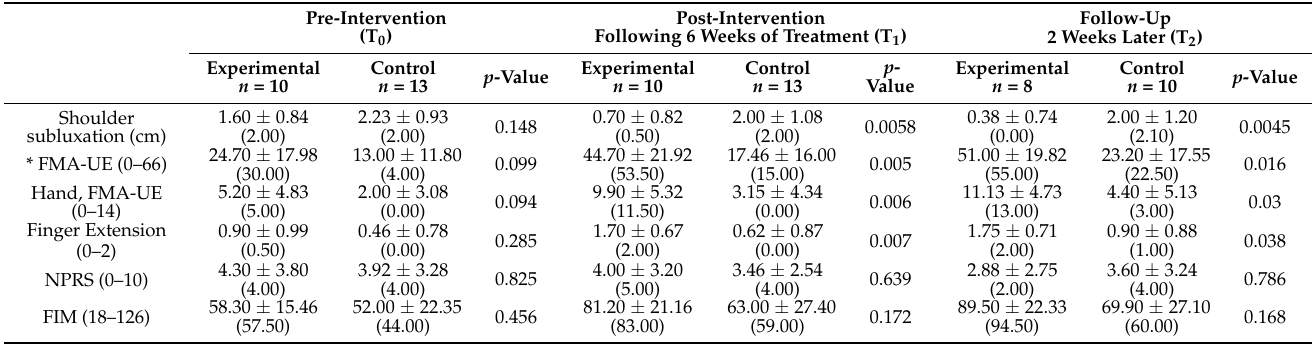
Table 2. Outcome measures pre- and post-intervention following 6 weeks of treatment and at follow-up 2 weeks later per group (mean ± standard deviation, (median)) and Wilcoxon two-sample test